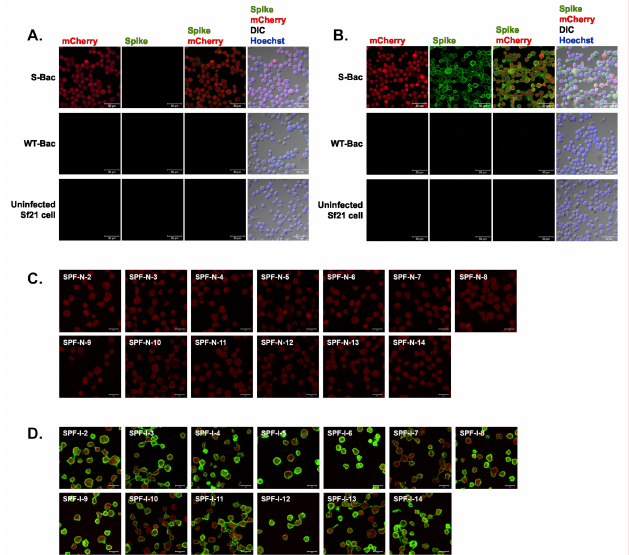
Figure 4. IFA of piglet antisera using Sf21 cells infected with S-Bac, WT-Bac, or uninfected Sf21 cells. Serum from SPF-N-1 ( A ) and SPF-I-1 ( B ) was used as primary antibody to interact with the cells, and the anti-S signal was detected by a secondary anti-swine green fluorescent antibody. For SPF piglets Nos. 2–14, only the merged image of anti-S (spike, green) and mCherry (red) signals are shown. DIC: differential interference contrast microscopy. ( C ) SPF-N, Nos. 2–14 ( D ) SPF-I, Nos. 2–14. Primary antibody: SPF-N or SPF-I serum with a dilution of 1:200. Secondary antibody: Alexa Fluor 488 goat anti-swine IgG with a dilution of 1:200. Bar: 50 µ